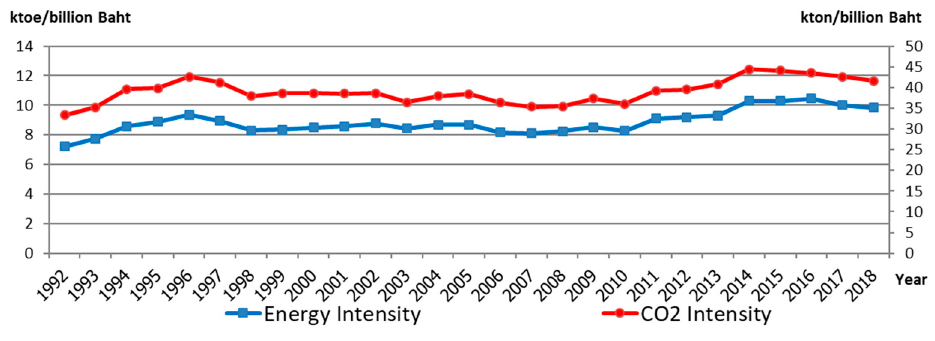
Figure 1. CO 2 emission intensity and energy intensity of the manufacturing sector, 1992 – 2018.